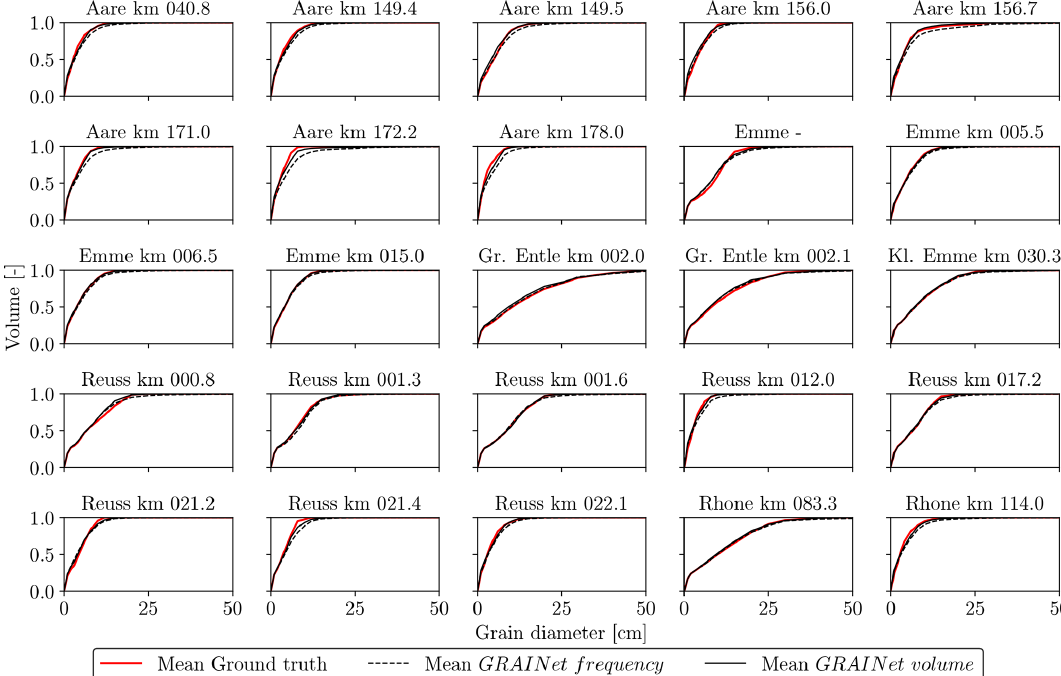
Figure 12. Grading curves of the 25 gravel bars, estimated with random 10-fold cross-validation.